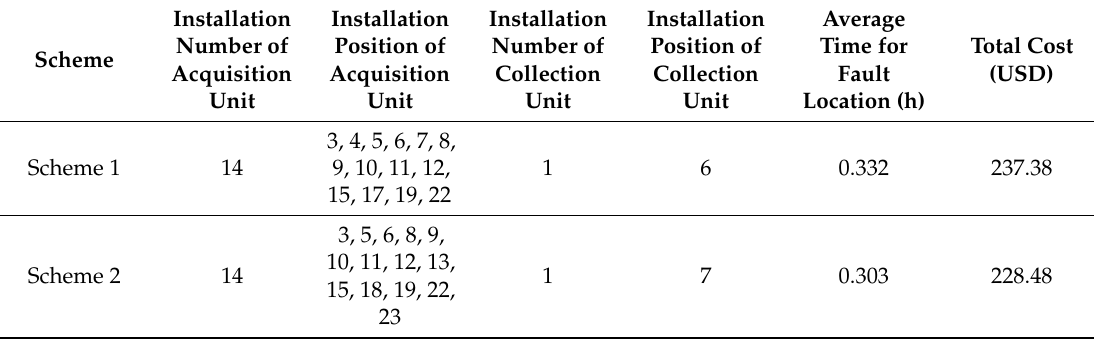
Table 1. Comparison of two configuration schemes of fault indicator.